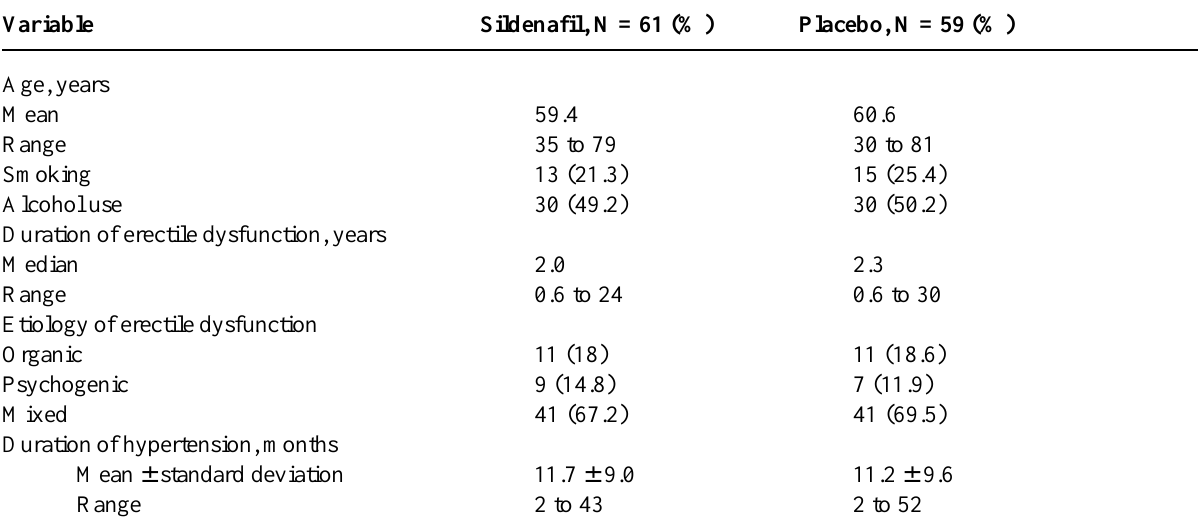
Table 1 – Patient characteristics at baseline (intent-to-treat sample, N = 120)